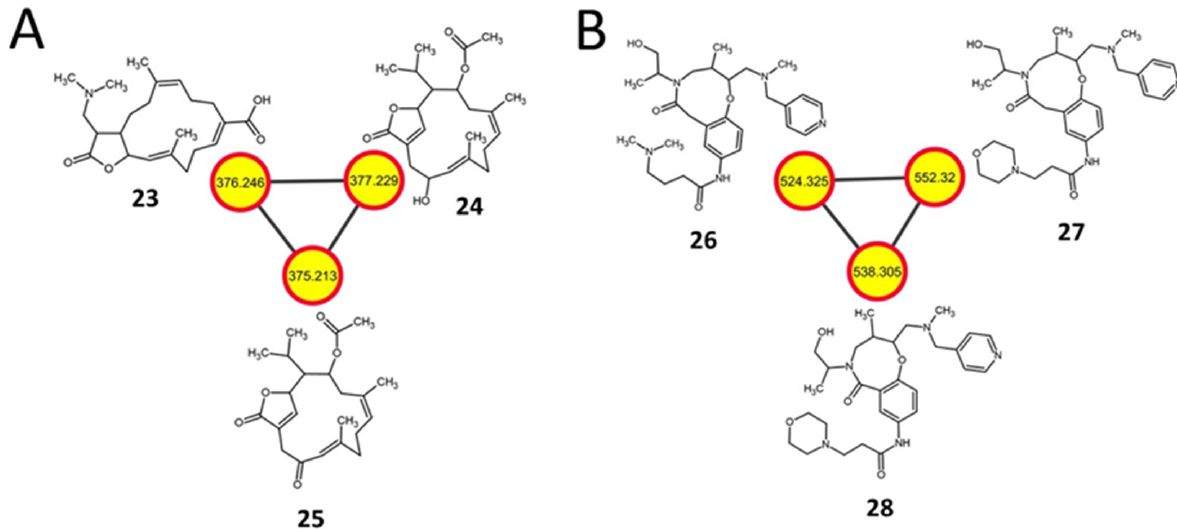
Figure 7. Examples of other molecular networks detected in S. clavuligerus strains engineered from the current study. ( A ) A positive ionization mode molecular network of cembrane diterpenoids present in S. clavuligerus strains overexpressing different rpsL variants (K88E, L90K, R94G). ( B ) A negative ionization mode molecular network of organooxygen and organonitrogen compounds detected in S. clavuligerus overexpressing rpsL only. The structures were predicted by GNPS-based molecular networking and network annotation propagation (NAP). Each node depicts a mass spectrum (labeled with m/z of the respective precursor mass) and the edges represent the relationship between different nodes. The top-ranked NAP-consensus structural predictions (red boundary) present in the overexpression strains (yellow fill) are shown.